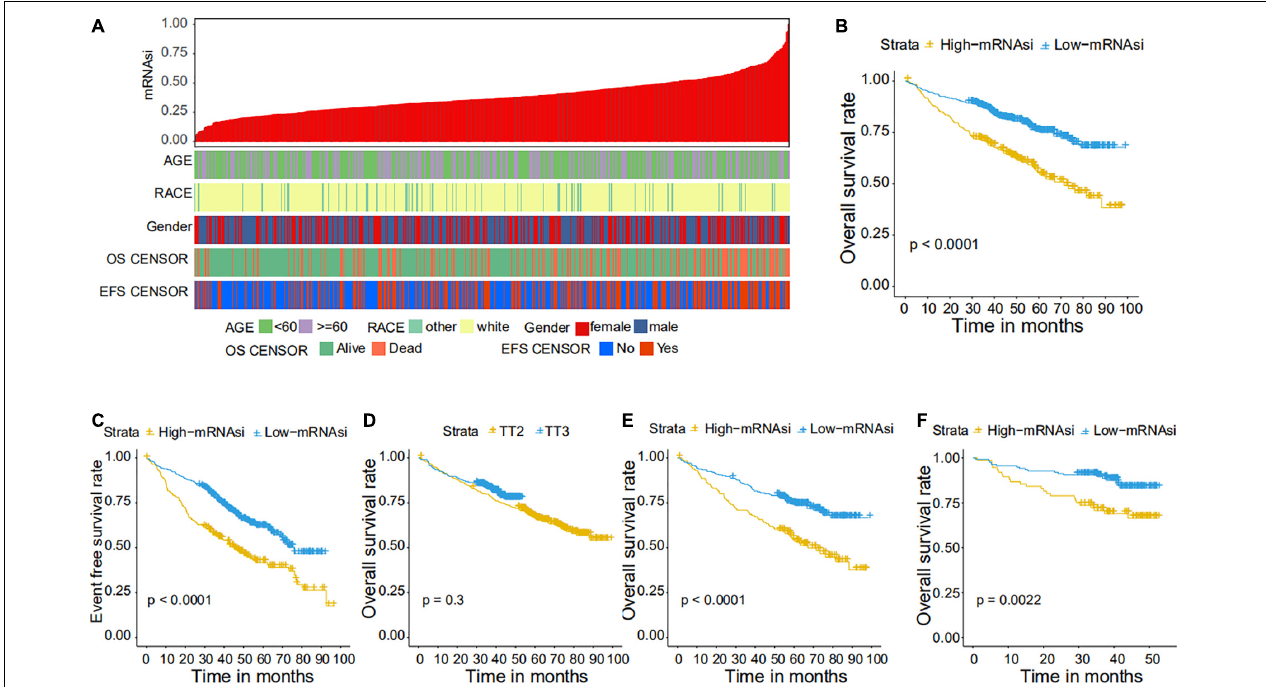
FIGURE 2 | Clinical characteristics related to the mRNA expression-based stemness index (mRNAsi) in the GSE24080 cohort. (A) Overview of the association between demographic characteristics and mRNAsi in MM. Columns represent samples sorted by mRNAsi from low to high (top row), and rows represent the demographic factors associated with mRNAsi. (B,C) The Kaplan–Meier curve was used to determine the overall survival (OS) (B) and event-free survival (EFS) (C) of patients in the multiple myeloma (MM) group with high and low mRNAsi. (D) The Kaplan–Meier curve was used to determine the OS of patients treated with the TT2 or TT3 regimen. (E) The Kaplan–Meier curve was used to determine the OS of high and low mRNAsi patients treated with the TT2 regimen. (F) The Kaplan–Meier curve was used to determine the OS of high and low mRNAsi patients treated with the TT3 regimen.